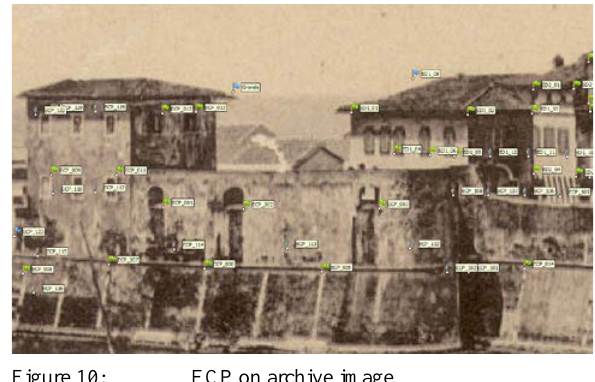
Figure 10: ECP on archive image